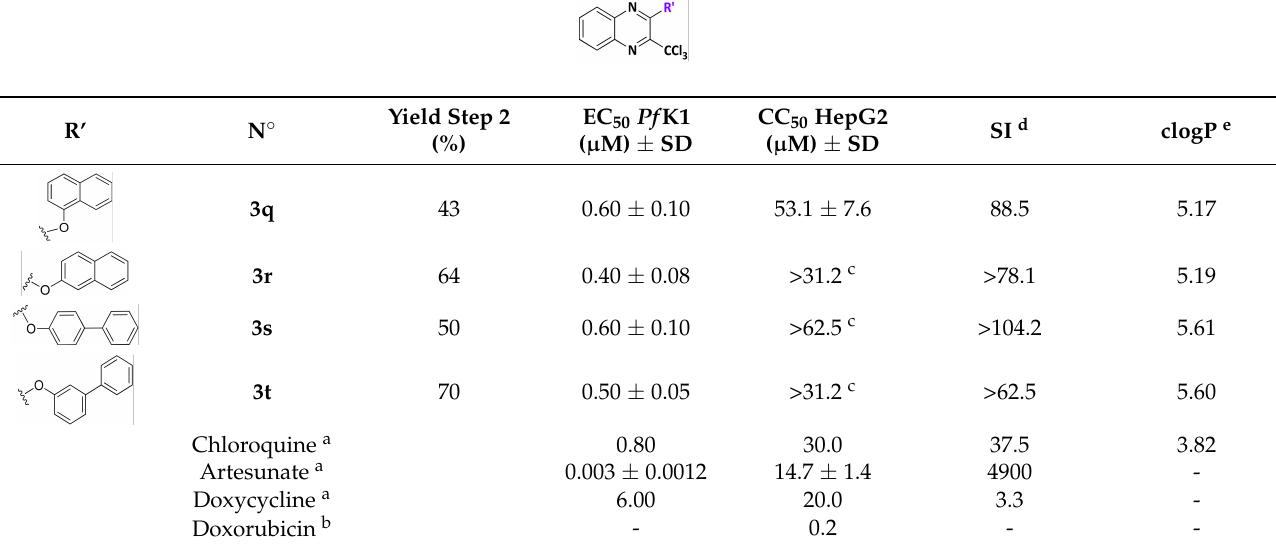
Reaction yields, antiplasmodial activity, HepG2 cytotoxicity, and clogP of the cluttered 3-phenoxy-2- trichloromethylquinoxalines 3q to 3t